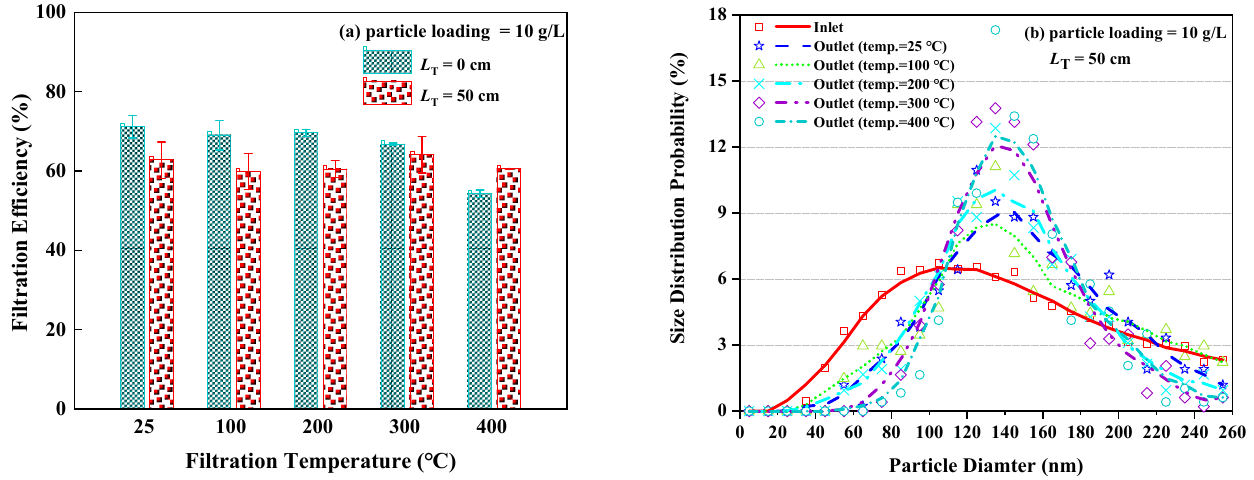
Figure 7. ( a ) Filtration efficiency for different transition section lengths with particle loading of 10 g/L; ( b ) size distribution probability of particle diameter in DPF inlet and outlet with particle loading of 10 g/L, transition section length L T of 50 cm.